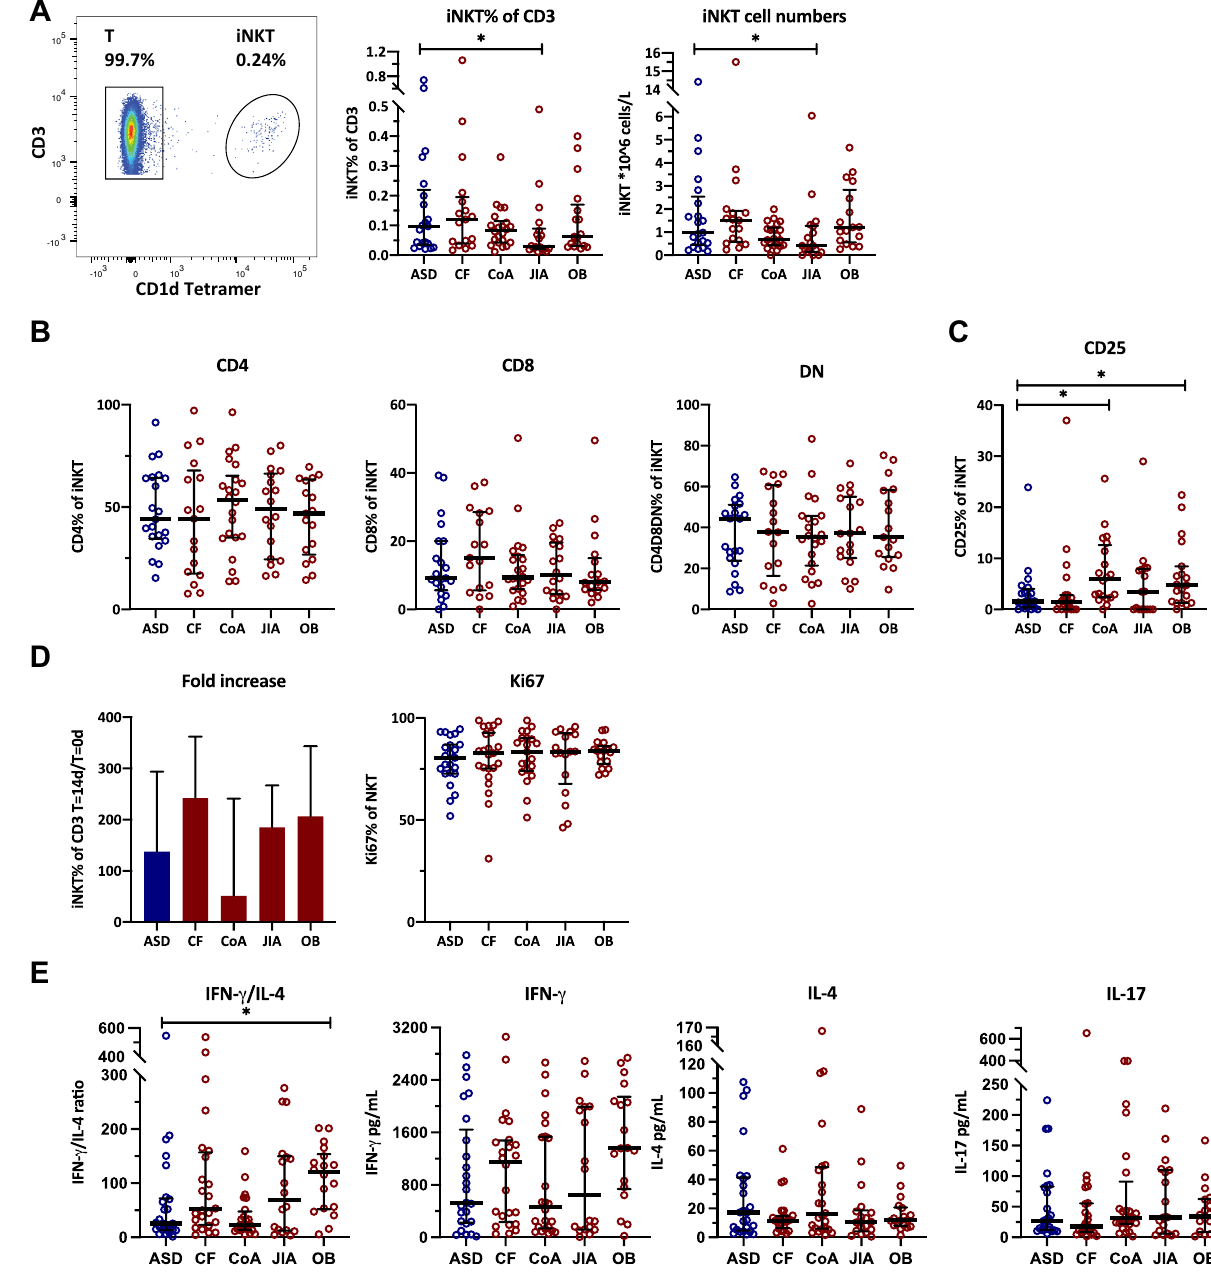
Figure 1. iNKT cell numbers and phenotype. ( A ) Circulating iNKT cell numbers presented as percentage of CD3 and as absolute numbers, measured using flow-cytometry of PBMC from patients with CF (n = 17), CoA (n = 22), JIA (n = 18), and obesity (n = 17), and compared with ASD controls (n = 17) using Kruskal–Wallis, followed by post-hoc Mann–Whitney U tests, * p < 0.05. Differences were not significant after multiple testing correction. ( B ) CD4, CD8 and double negative (DN) iNKT subset division. ( C ) iNKT cell CD25 expression at T = 0. The observed differences were not significant after multiple testing correction. ( D ) iNKT cell proliferation and Ki-67 expression after 14 days culture following α-GalCer stimulation. ( E ) iNKT cell cytokine production measured in supernatant using multiplex immunoassay, after 11 days culture following α-GalCer stimulation of PBMC from patients with CF (n = 24), CoA (n = 24), JIA (n = 18), and obesity (n = 18), compared with ASD controls (n = 25) using Kruskal–Wallis, followed by post-hoc Mann–Whitney U tests, * p < 0.05. Differences remained significant after multiple testing